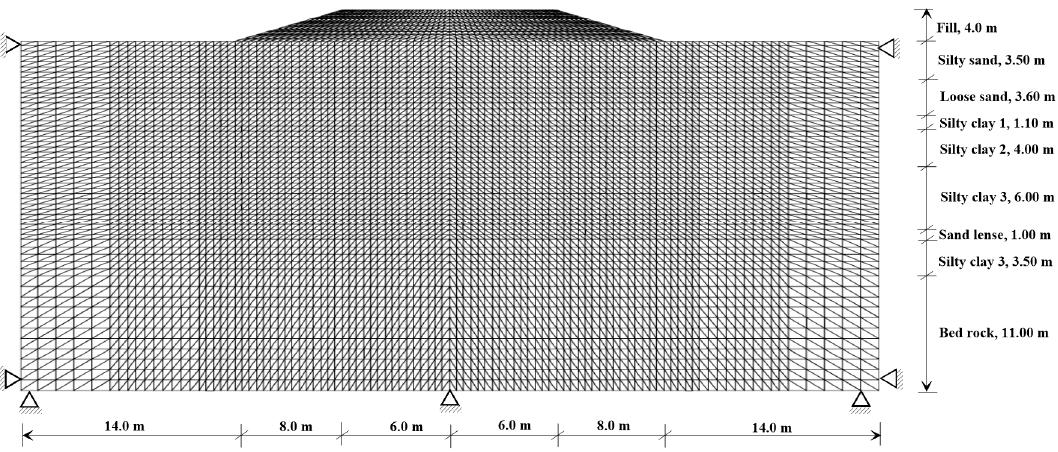
Figure 13. Finite element geometry of the Nerang Broadbeach Roadway embankment. Table 4. Model parameters for the Nerang Broadbeach Roadway embankment.